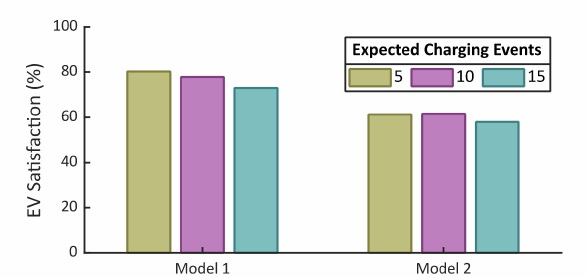
Figure 11. Percentage of the expected EV demand actually satisfied in various scenarios.